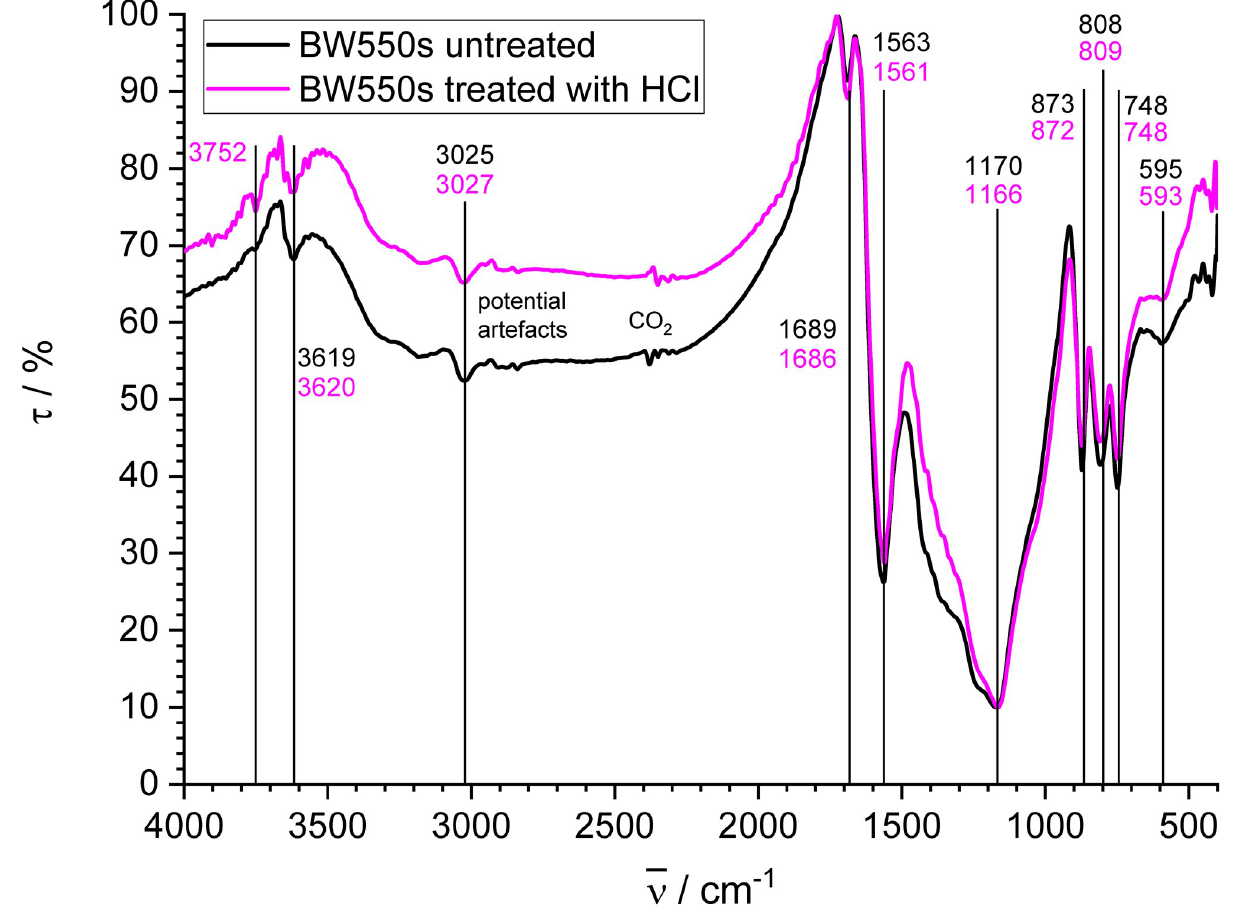
Fig 6. FT-IR spectra of BW550s made by slow pyrolysis (untreated and treated with HCl).